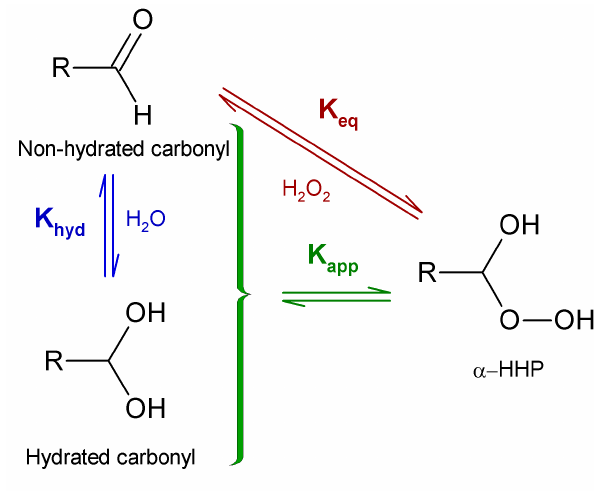
Fig. 4. Hydration equilibrium constant ( K hyd ) , the α -HHP forma- tion equilibrium constant ( K eq ) and the apparent α -HHP formation equilibrium constant ( K app ) . Please see the text for